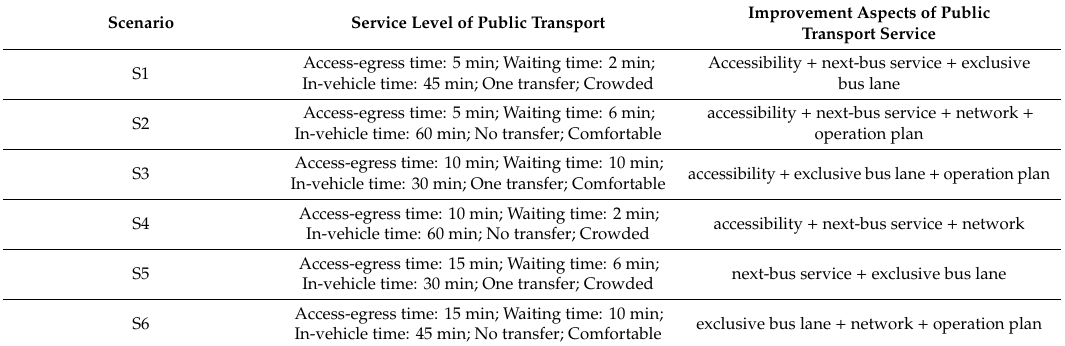
Table 4. Results of mixed-level uniform